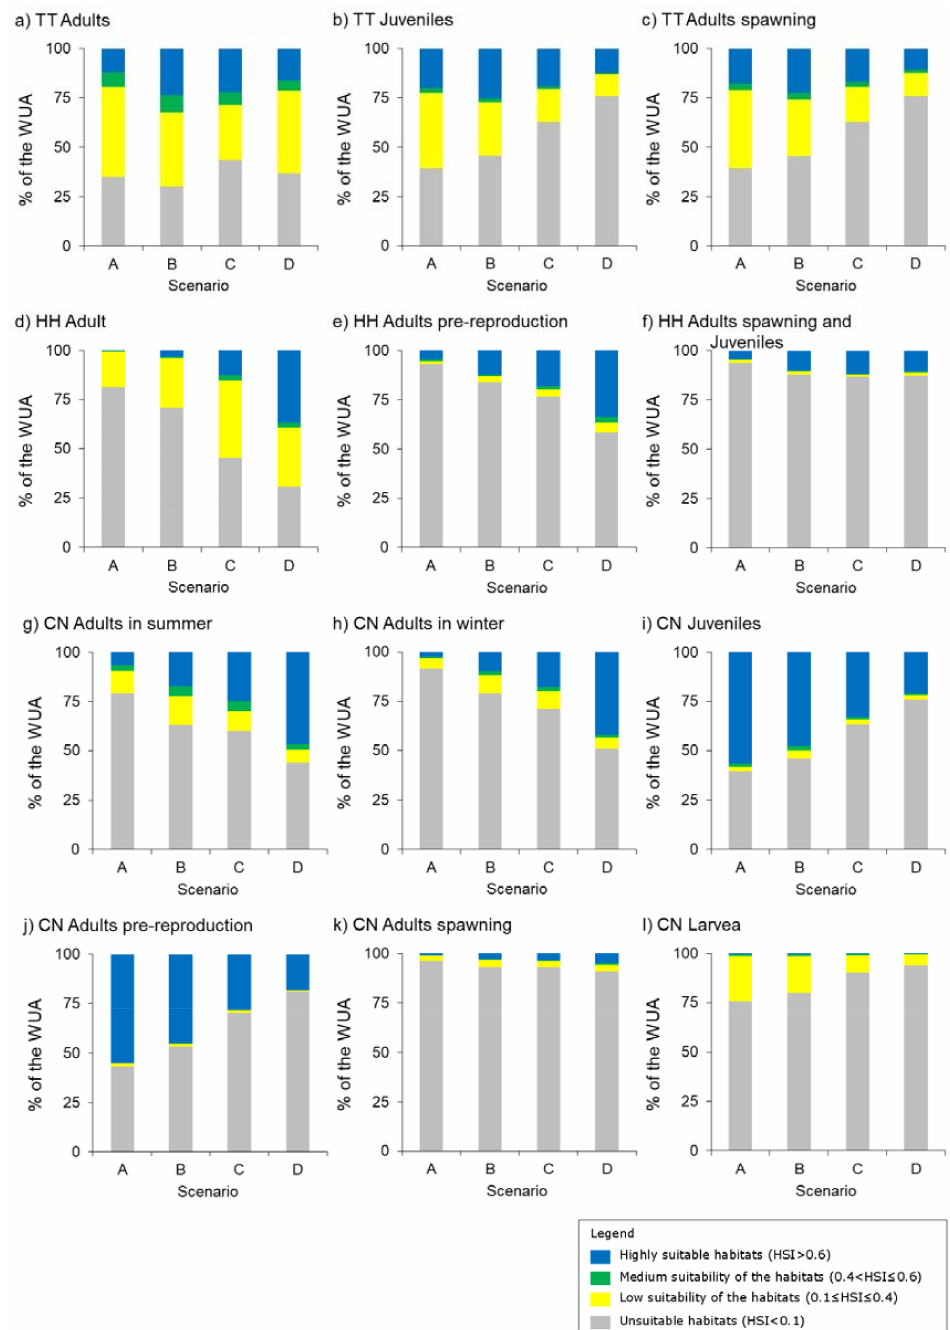
Figure 5. Percent of the Weighted Usable Area (WUA) that is characterized from highly suitable to unsuitable habitats for each scenario considering each habitat type of Thymallus thymallus L. ( a – c ), Hucho hucho L. ( d – f ), and Chondostroma nasus L. ( g – l